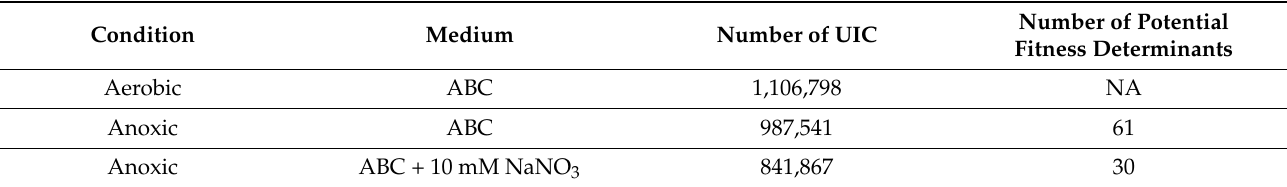
Table 1. Number of B. cenocepacia H111 unique insertion counts (UIC) and potential fitness determi- nants identified in each tested condition. NA = not